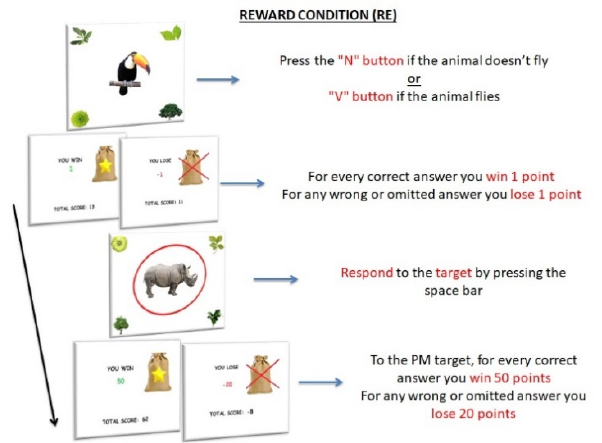
Figure 5. Procedure of Reward condition (RE). The items consisted of 120 images of an animal located at the center of the screen; images of plants were located at the four corners of the screen. As in the BC, participants had to press the “N” button when the image of a non-flying animal appeared on the screen and the “V” button when the image of a flying animal appeared on the screen (ongoing task). However, when a rhinoceros—PM target—appeared at the center of the screen (12 trials), participants were required to press the spacebar (PM task), instead of the semantic decision Table 2 seconds. In the ongoing task, they received 1 RP for every correct answer and lost 1 RP for any wrong or omitted answer. In the PM task, they received 50 RP for every correct PM answer and lost 20 RP for any wrong or omitted PM